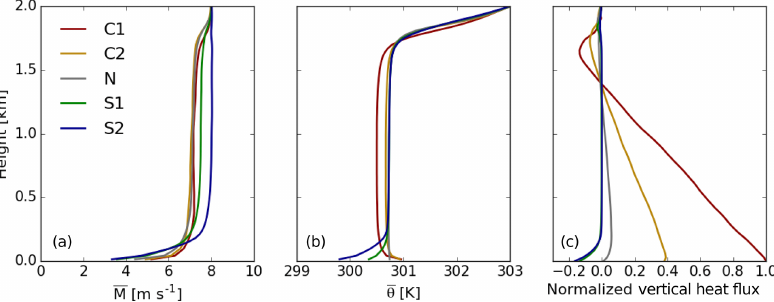
Figure 3. Vertical profiles of average wind speed (a) , temperature (b) , and normalized vertical sensible heat flux (c) are shown for the C1, C2, N, S1, and S2 cases colored red, yellow, gray, green, and blue, respectively. The normalized vertical sensible heat flux profiles are normalized with respect to the average surface sensible heat flux of the C1